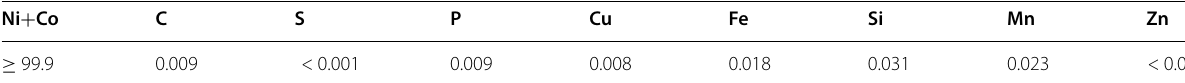
Table 1 Chemical composition of pure Ni (N4) (mass fraction /%)